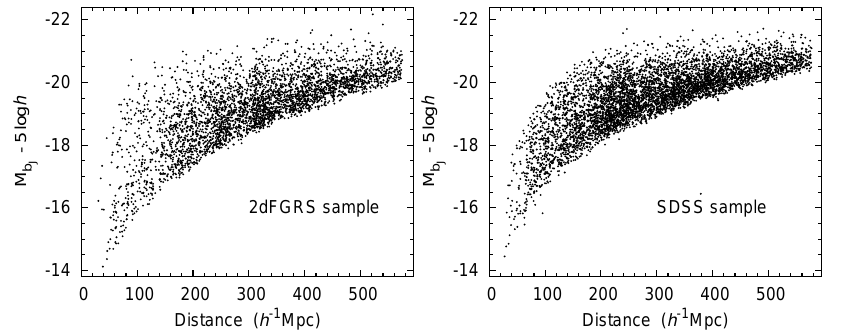
Fig. 1. Absolute magnitudes of galaxies in the 2dFGRS sample and in the SDSS sample at various distances from the observer. To have a better comparison between these two samples, the magnitudes of the SDSS sample were converted to the b J